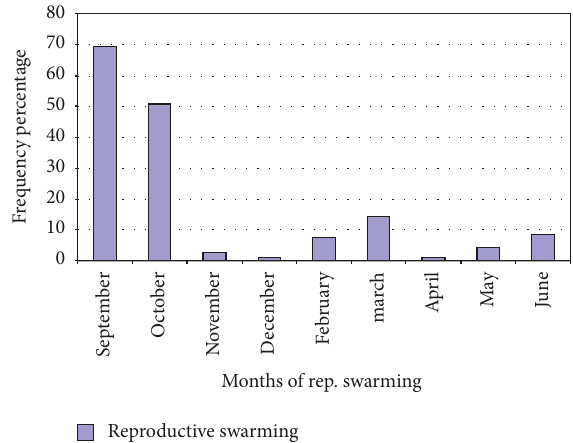
Figure 2: Number and types of local honeybee colonies swarmed from different hives during study. Figure 3: The reproductive swarming months of the